Question: Give a one-sentence summary of this figure.
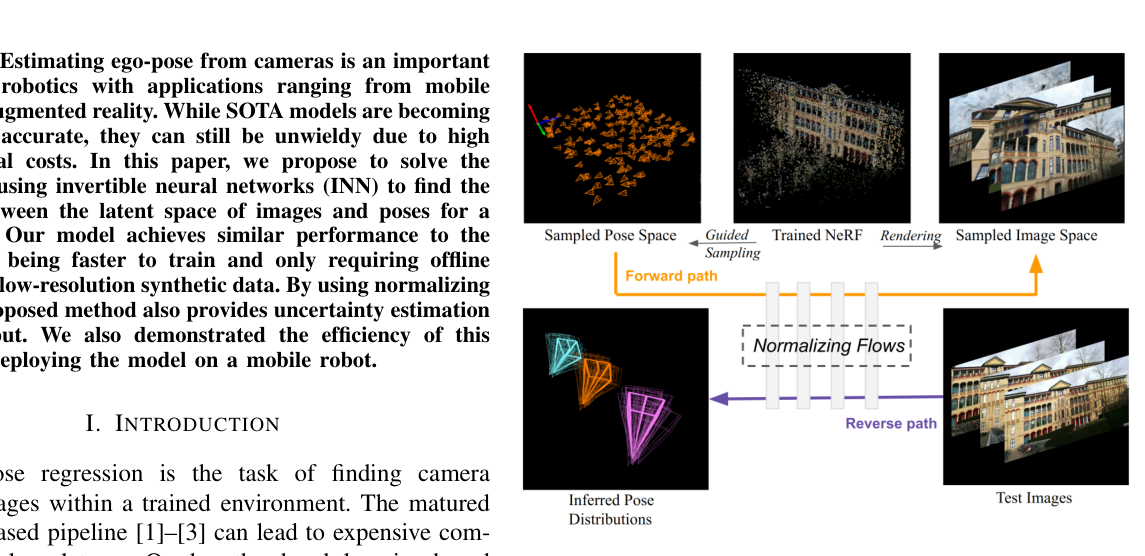
Answer: We propose to learn a mapping between the latent space of the images and camera poses in an environment with an invertible neural network. We use NeRF to guide camera pose sampling and render synthetic images. Evaluating the reverse path of the INN outputs the full posterior distribution of camera poses given a test image.